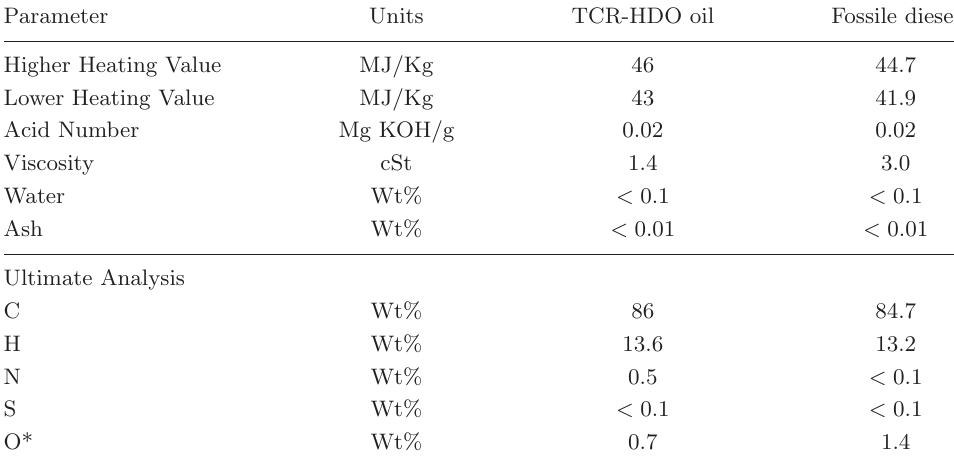
Table I. – Properties of TCR-HDO oil compared to fossile diesel.